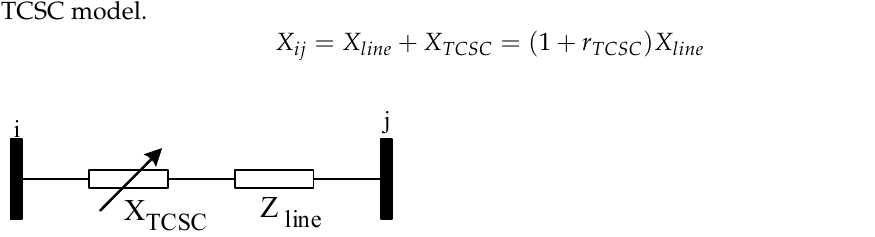
Figure 3. Single-line diagram of a Thyristor Controlled Series Compensator model.